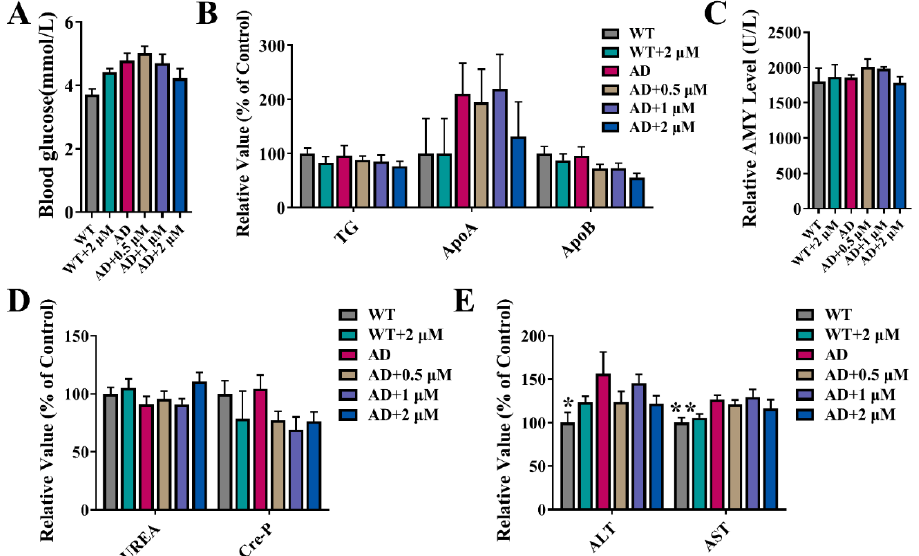
Figure 1. Effect of Ebselen on biochemical indicators of 9-month-old AD mice: ( A ) The level of blood glucose; ( B ) relative levels of blood-lipid-related biochemical indicators, including triglyceride (TG), apolipoprotein A (ApoA) and apolipoprotein B (ApoB); ( C ) the level of α -amylase (AMY); ( D ) relative levels of kidney-related biochemical indicators, including urea (UREA) as well as creatinine (Cre-P). ( E ) Relative levels of liver-related biochemical indicators, including glutamine transferase (ALT) and aspartate transferase (AST). (* p < 0.05, ** p < 0.01 vs. AD group; n = 12).